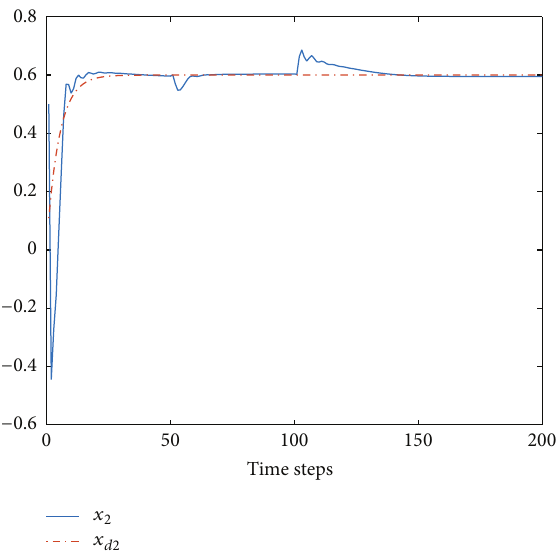
Figure 7: The state trajectory 𝑥 2 and desired trajectory 𝑥 𝑑2 .